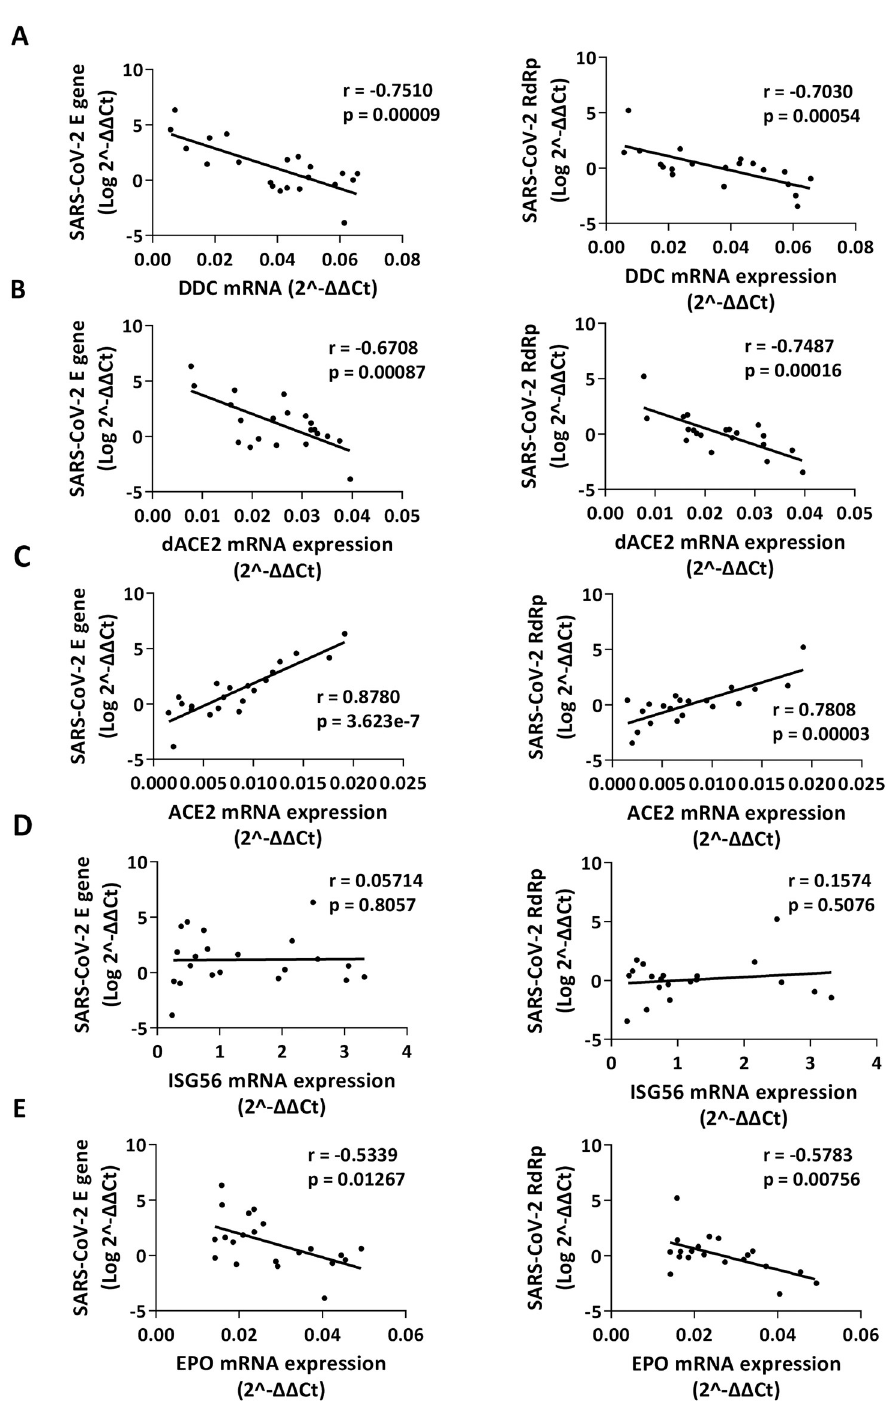
Fig 5. XY scatter plot and fitted linear regression lines of SARS-CoV-2 E (left) and RdRp (right) RNA levels versus DDC (A), dACE2 (B), ACE2 (C), ISG56 (D) and EPO (E) mRNA expression. Viral RNA levels were determined using primers specific for E (n = 21) and/or RdRp (n = 20) coding regions. Viral load was log transformed (base 10) prior to calculation of the Pearson’s correlation coefficient ( r ) and p values ( p ).